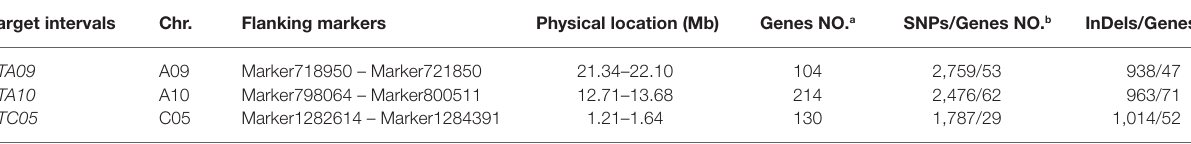
TABLE 4 | Details of target